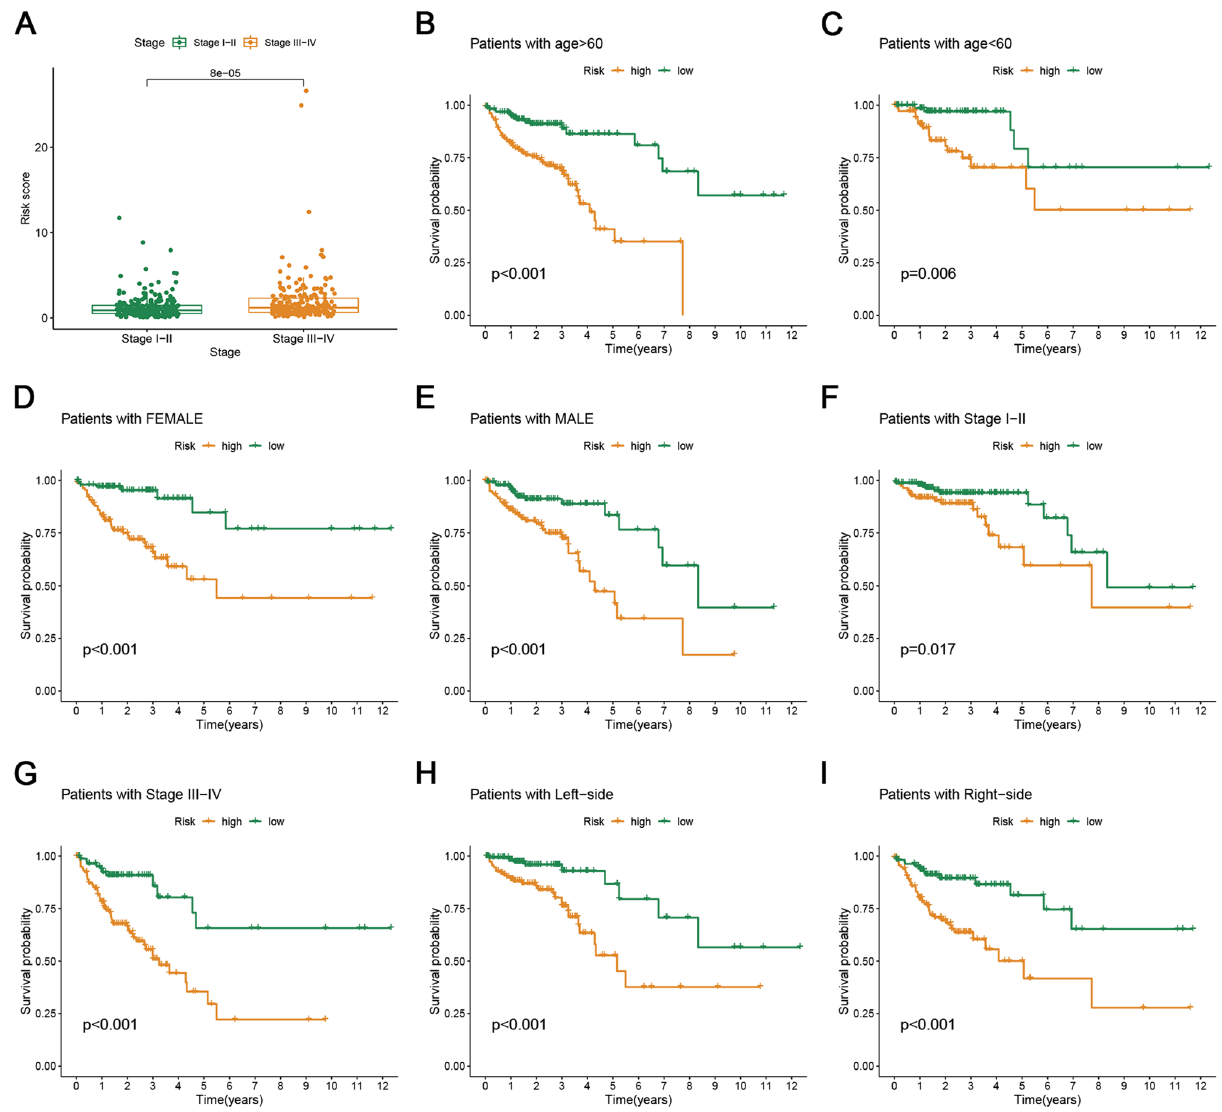
( B ), < 60 years of age ( C ), female sex ( D ), male sex ( E ), stage I–II ( F ), stage III–IV ( G ), left side ( H ), and right side ( I